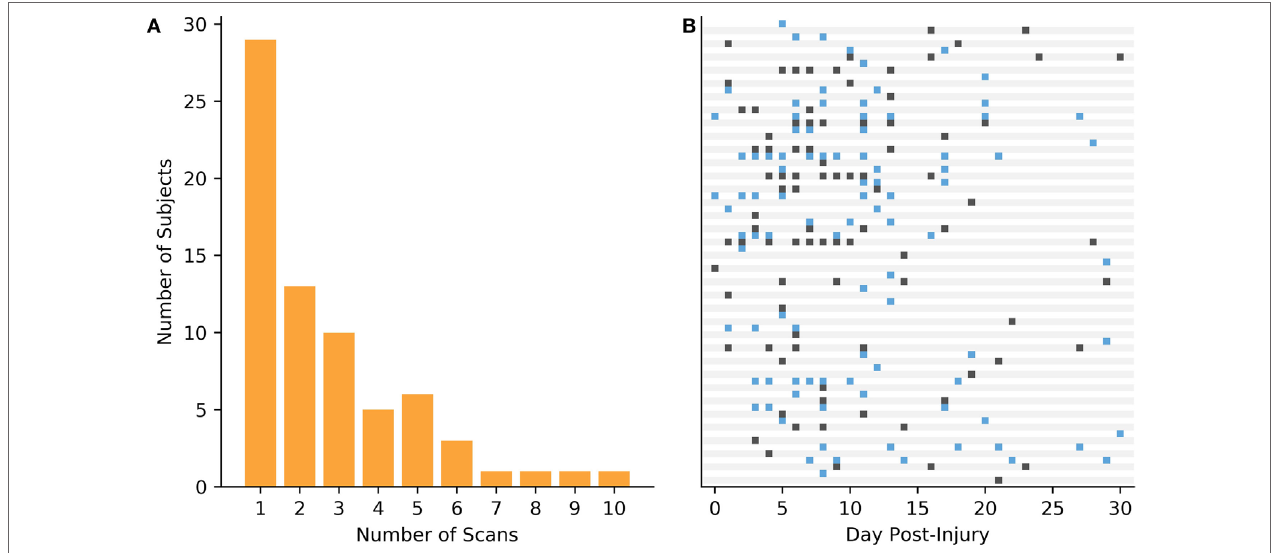
FigUre 1 | Data collection for the mild traumatic brain injury (mTBI) subjects. (a) Breakdown of the frequency that the subject population was scanned. (B) Scan times in days post-injury for each of the mTBI